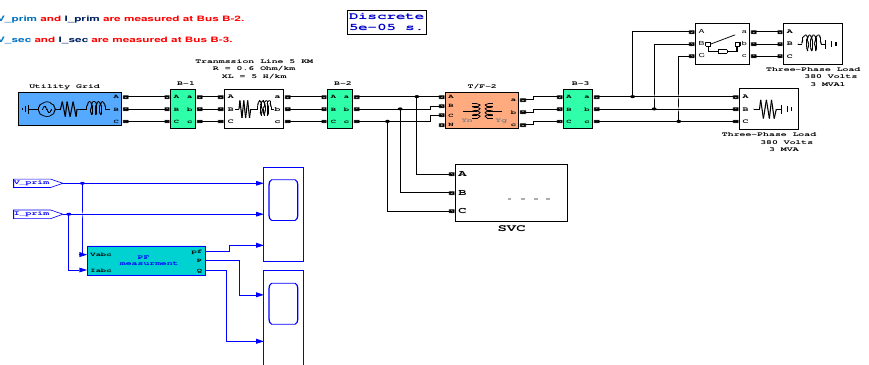
FIG. 3. POWER SYSTEM WITH STATIC VAR COMPENSATION